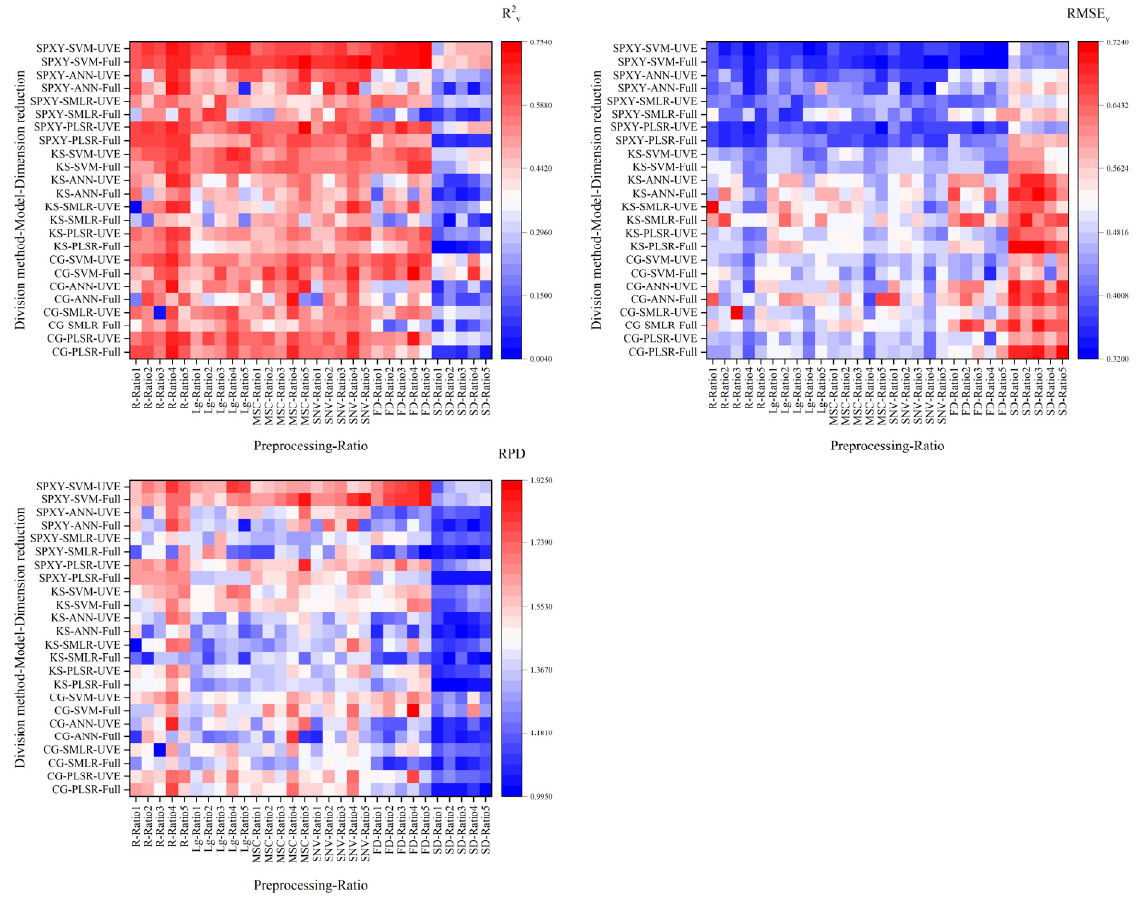
Figure 9. Accuracy of validation set model. Table 2. Correlation between each factor and RMSE v .